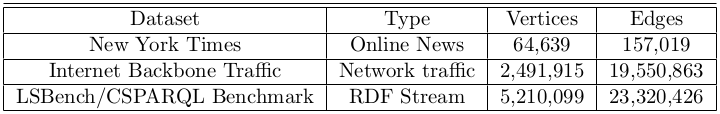
Table from the paper: Query Optimization for Dynamic Graphs
Table text:
Dataset
Type
Vertices
Edges
New York Times
Online News
64,639
157,019
Internet Backbone Traﬃc
Network traﬃc
2,491,915
19,550,863
LSBench/CSPARQL Benchmark
RDF Stream
5,210,099
23,320,426